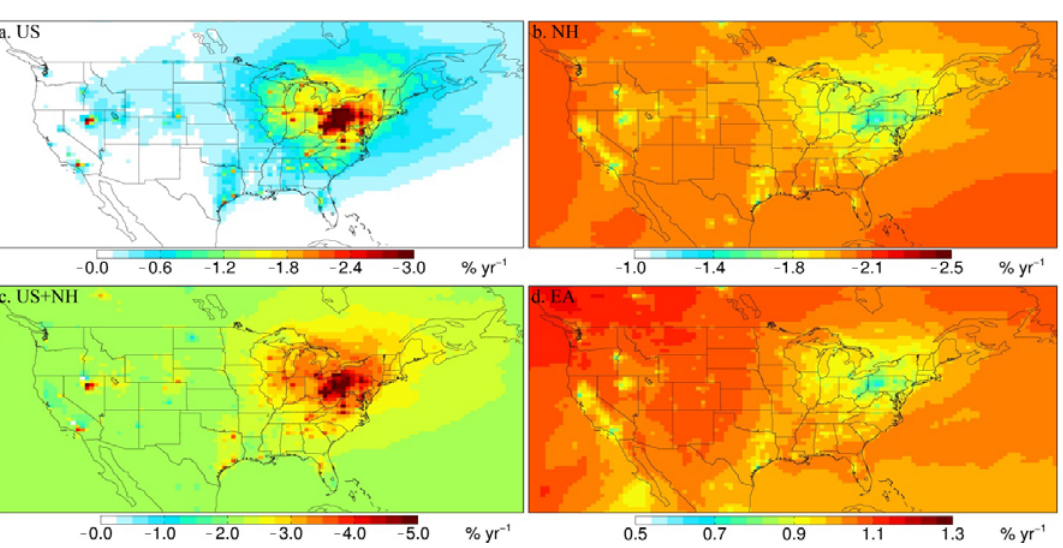
Figure 5. Calculated trends (% yr − 1 ) in VWM Hg concentrations over the US for scenarios US, NH and EA, compared with the BASE simulation. ( a ) Trend for US scenario (45% reduction of Hg emissions from domestic sources); ( b ) trend for NH scenario (12% decrease of Hg background atmospheric concentrations); ( c ) combined US and NH scenarios; ( d ) trend for EA scenario (32% increase in Hg emissions from East